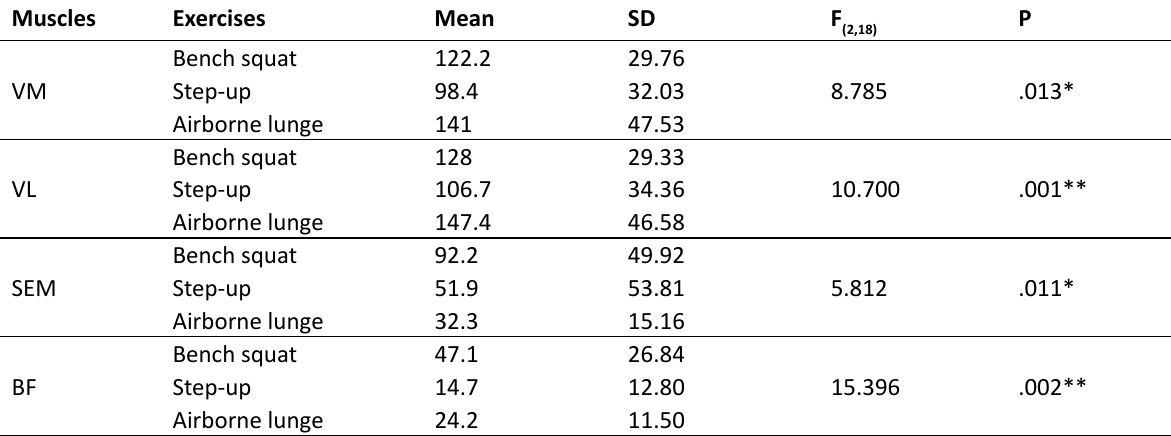
Table 3. Q:H ratio of mean RMS values for the entire movement Exercise VM+VL/SEM+BF P Bench squat 2.55